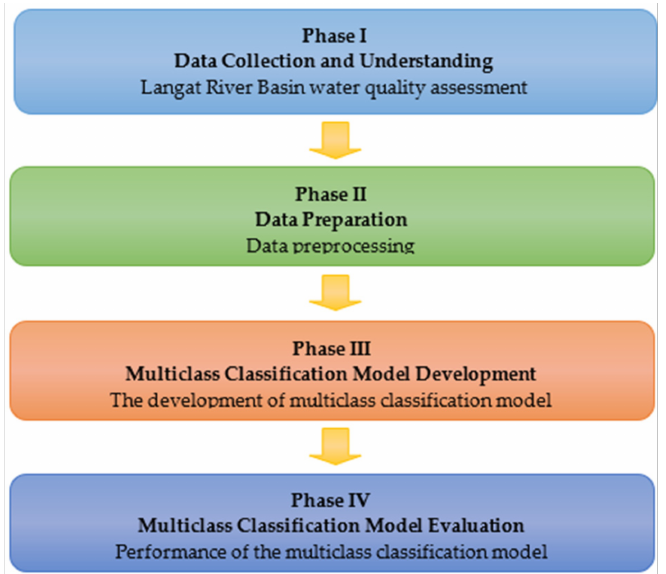
Figure 2. The main phases of the study